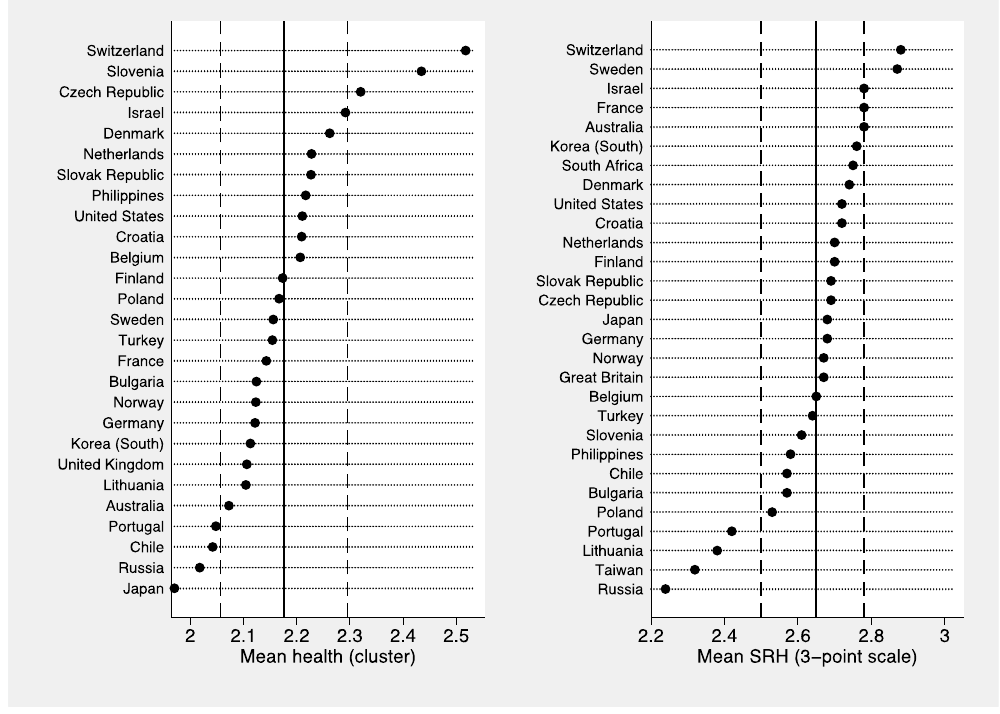
Figure 1. Inter-country comparison according the final three group classification ( left ) and self-rated health ( right ).